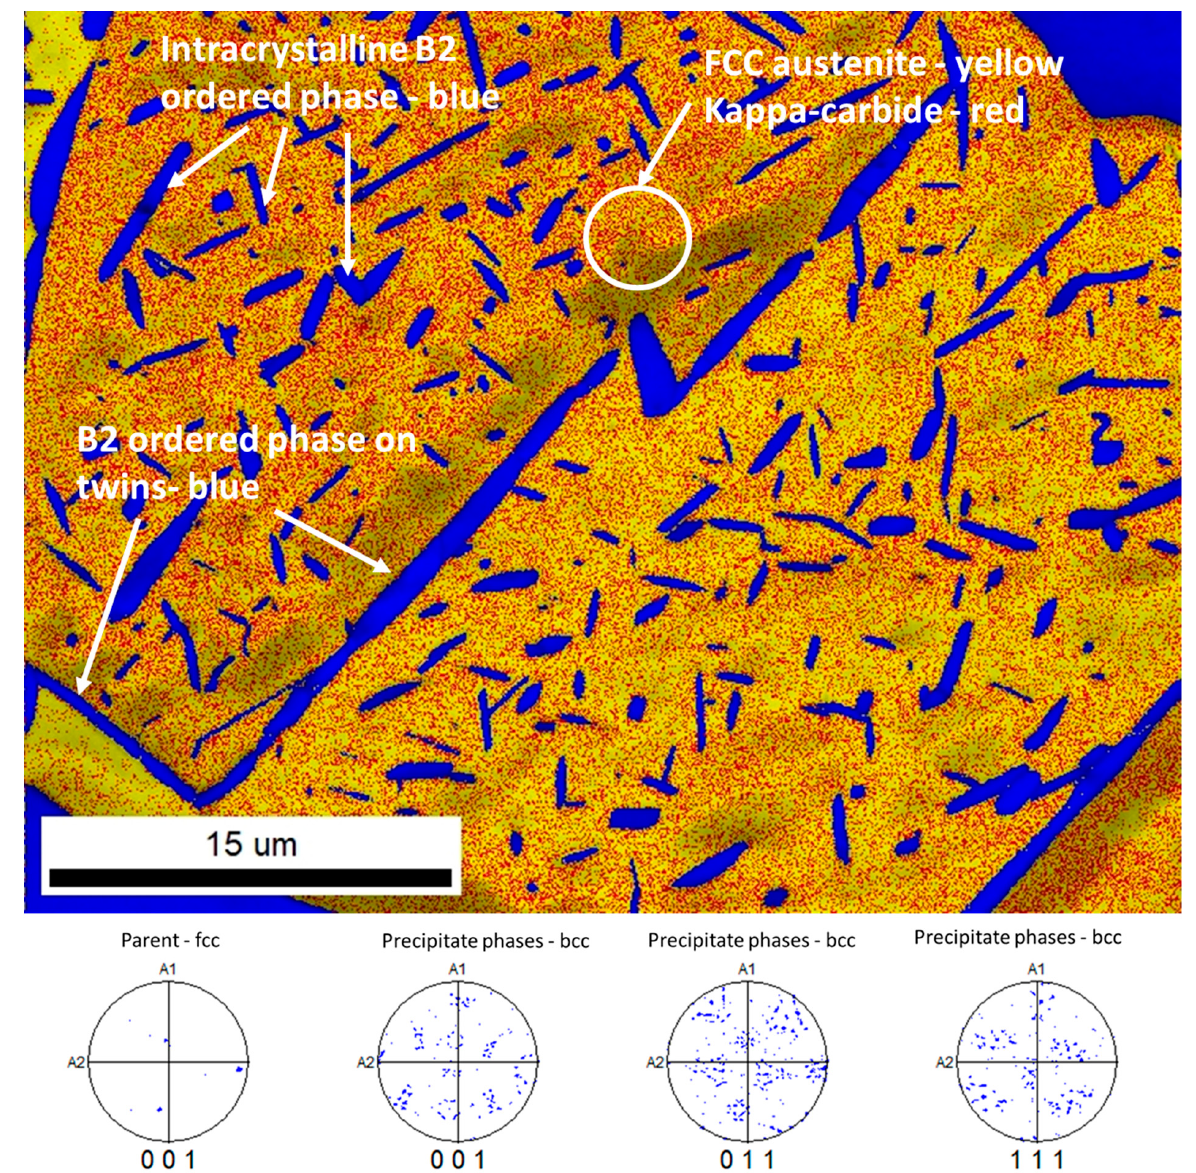
Figure 15. Results of EBSD analysis of the sample annealed at 850 °C, where the Kurdjomov–Sachs-like orientation relation proves the coherence of the FCC matrix and the BCC B2 ordered precipitates. Detailed analysis of the precipitates in austenite.